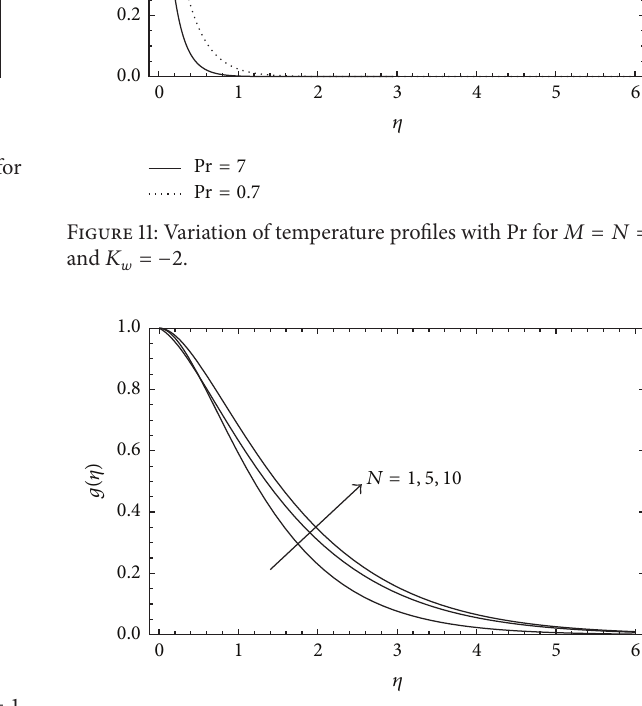
Figure 12: Variation of temperatureprofiles with 𝑁 for 𝑀 = 1, Pr = 0.7 , and 𝐾 = 2 𝑤